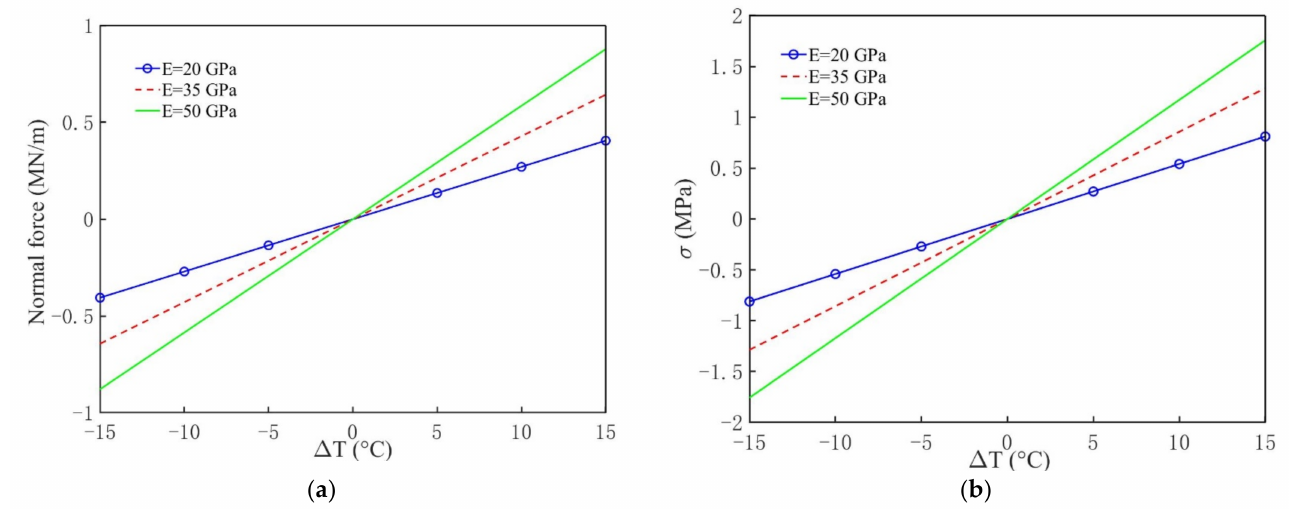
Figure 7. Impact of ∆ T on the internal forces of tunnel lining considering different E : ( a ) Normal force; ( b ) Stress of lining.